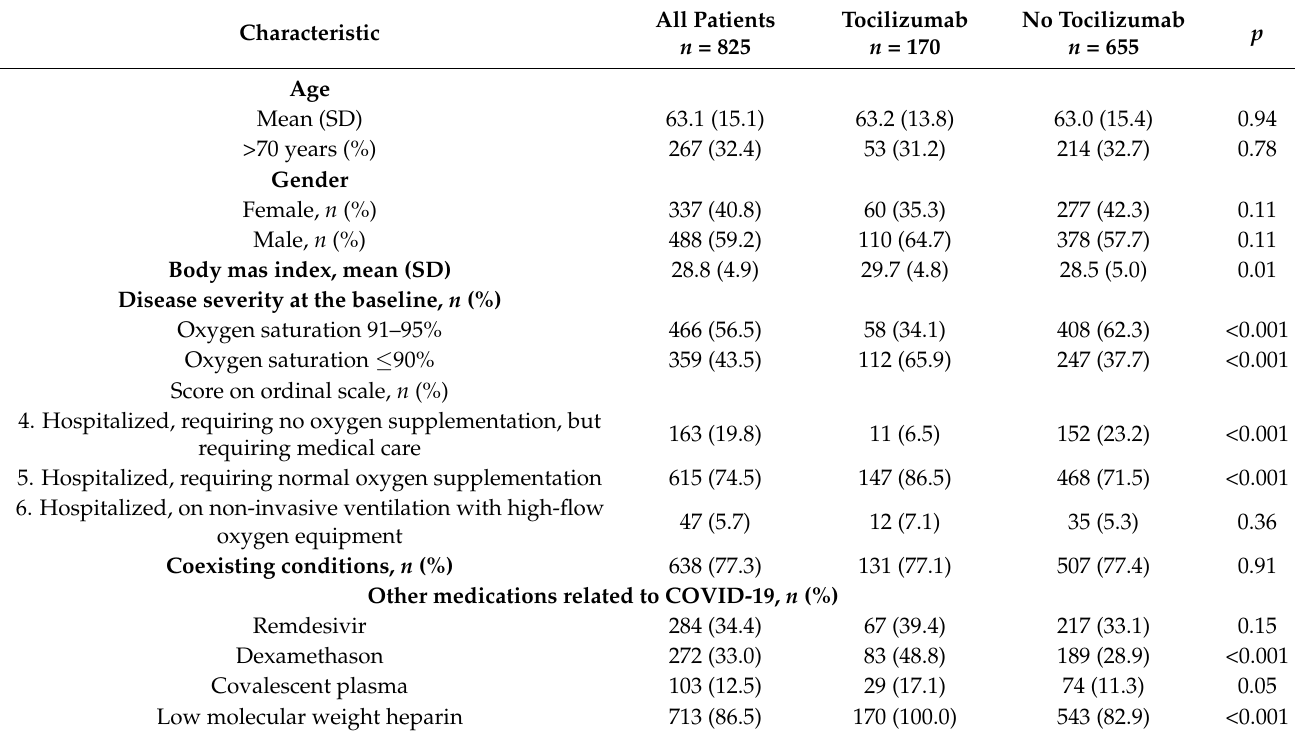
Table 1. Baseline demographic and clinical characteristics of included patients.